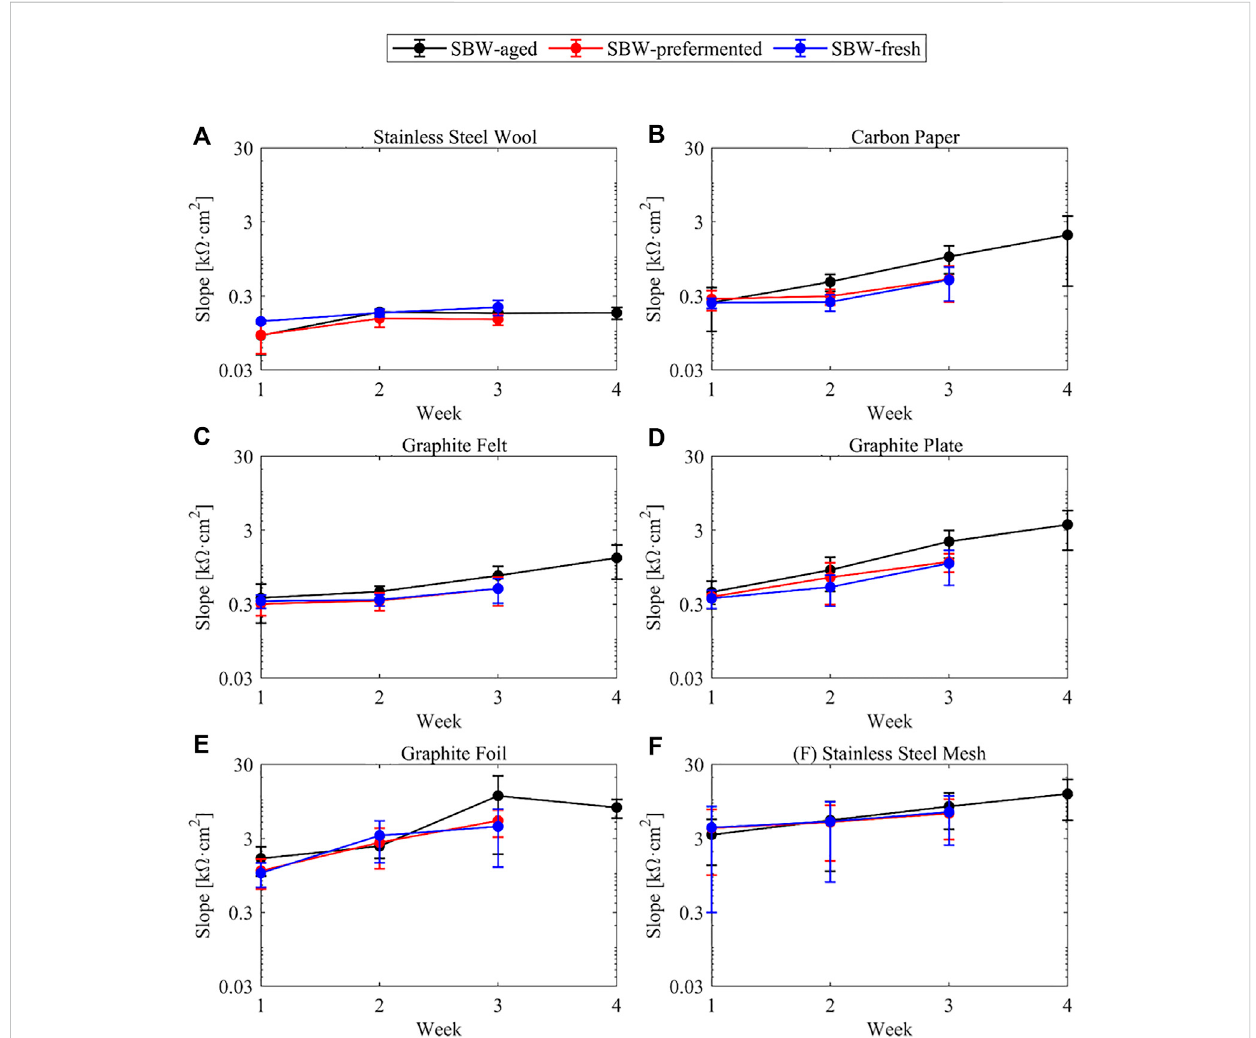
Slope of the bioanodes in the ohmic region throughout the weeks of the experiment in logarithmic scale and bound with lines for visual aid. (A) Stainless-steel wool (B) Carbon paper (C) Graphite felt (D) Graphite plate (E) Graphite foil (F) Stainless-steel